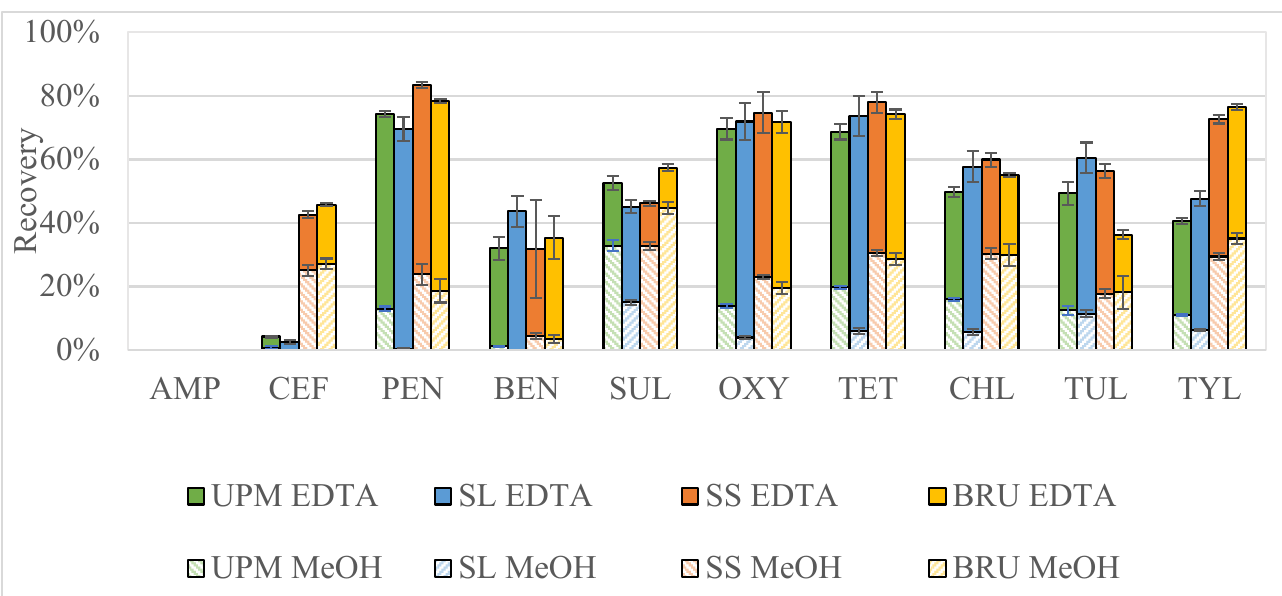
Figure 3. Extraction recoveries of antibiotics from four types of manure processed through a manure treatment system (graphed from left to right within each antibiotic): unprocessed manure (UPM), liquid separated manure (SL), solid separated manure (SS), and manure treated using a bedding recover unit (BRU). The extraction was a two-step process with an EDTA-McIlvaine buffer as the first extractant (EDTA, top half of the bar) and MeOH as the second (bottom half of the bar). Values from each extraction fraction are averages (n = 3) with ± standard error bars. The antibiotics examined include Ampicillin (AMP, not recovered), Ceftiofur (CEF), Penicillin-G (PEN), Benzylpenicilloic Acid (BEN), Sulfadimethoxine (SUL), Oxytetracycline (OXY), Tetracycline (TET), Chlortetracycline (CHL), Tulathromycin-A (TUL), and Tylosin Tartrate (TYL). While most of the antibiotics in the SL manure were extracted in the first extraction step using the EDTA-McIlvaine buffer (>67% for all antibiotics), the extraction recoveries for manure with higher solids content ranged from 22–96%, with an average of 63 ± 3.6%. The heightened recovery in the first extraction step (EDTA-McIlvaine buffer) for the SL manure over the other manure types indicates that the antibiotics in the SL manure are mainly in the aqueous phase and not associated with any remaining fine solids in the sample; even though the TS in all samples was held constant (~0.25 g TS/g manure) when samples were prepared for extraction (Table 2). The RSDs for the recoveries of all antibiotics across the four manure types were 3–21% except for CEF (RSD 99%) and TYL (RSD 30%), indicating that this initial two-step method was appropriate as a one-size-fits all extraction approach for most of the antibiotics in this study. The reduced recoveries of CEF and TYL in the UPM and LS samples could be due to the rapid degradation of CEF and TYL in the presence of microorganisms, which would be present in higher bacterial loads in the liquid samples compared to the treated manures [8,15]. Even though CEF and TYL had reduced extraction efficiencies for the more liquid substrates, average recoveries for all antibiotics in all samples were >32%, except CEF (4–46%) and AMP (not recovered). Lower recovery for CEF and AMP is likely due to β -lactam antibiotics being unstable in manure matrices [9]. The performance of this single extraction method on a range of manure types was consistent for most antibiotics and indicates that basing the mass of manure extracted on the TS concentration was a viable sample preparation approach and eliminates the need for multiple antibiotics extraction methods for different manure matrices moving